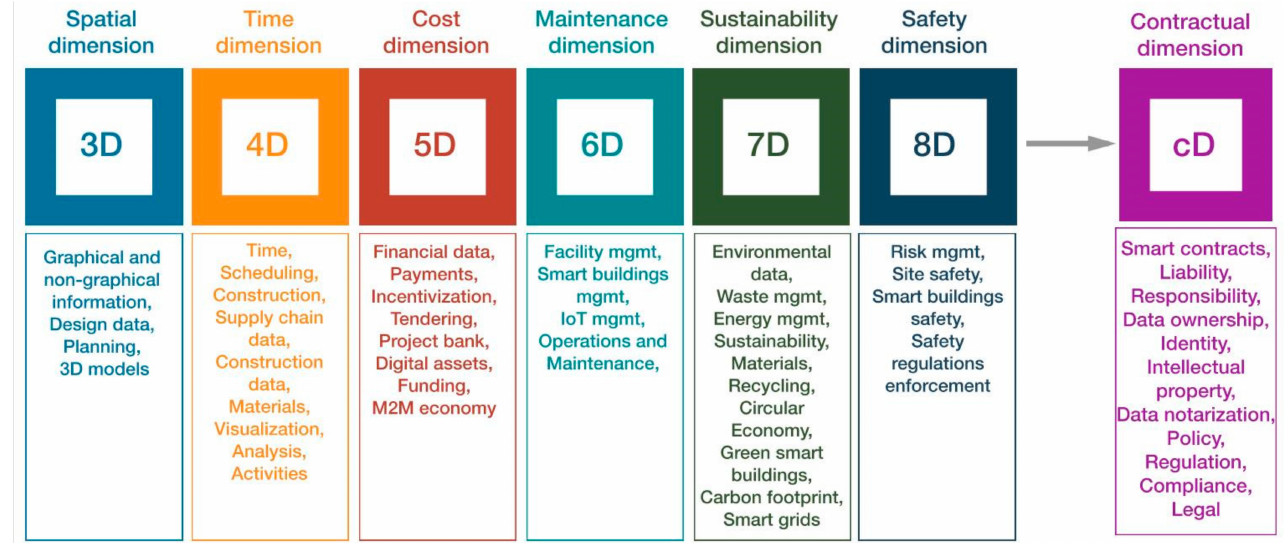
Figure 3. BCDT dimensions with the proposed contractual dimensions (cD). Note: In some countries, 6D refers to sustainability and 7D to